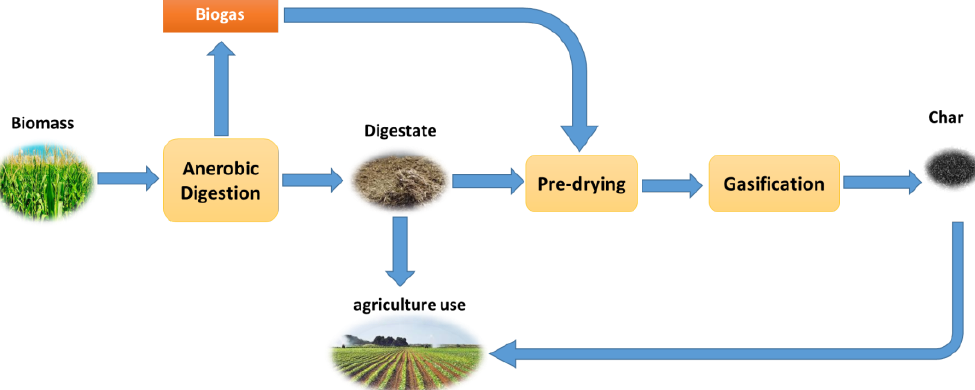
Figure 1. Coupling pathway for gasification of digestate Anaerobic Digestion and